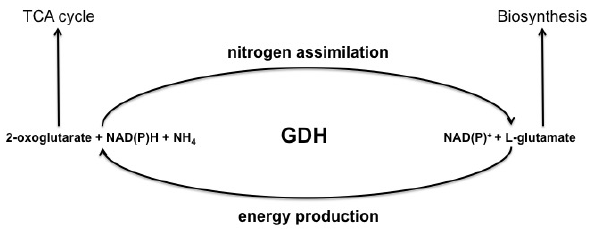
Figure 1. Schematic presentation of the reactions catalyzed by glutamate dehydrogenase and their general metabolic significance.